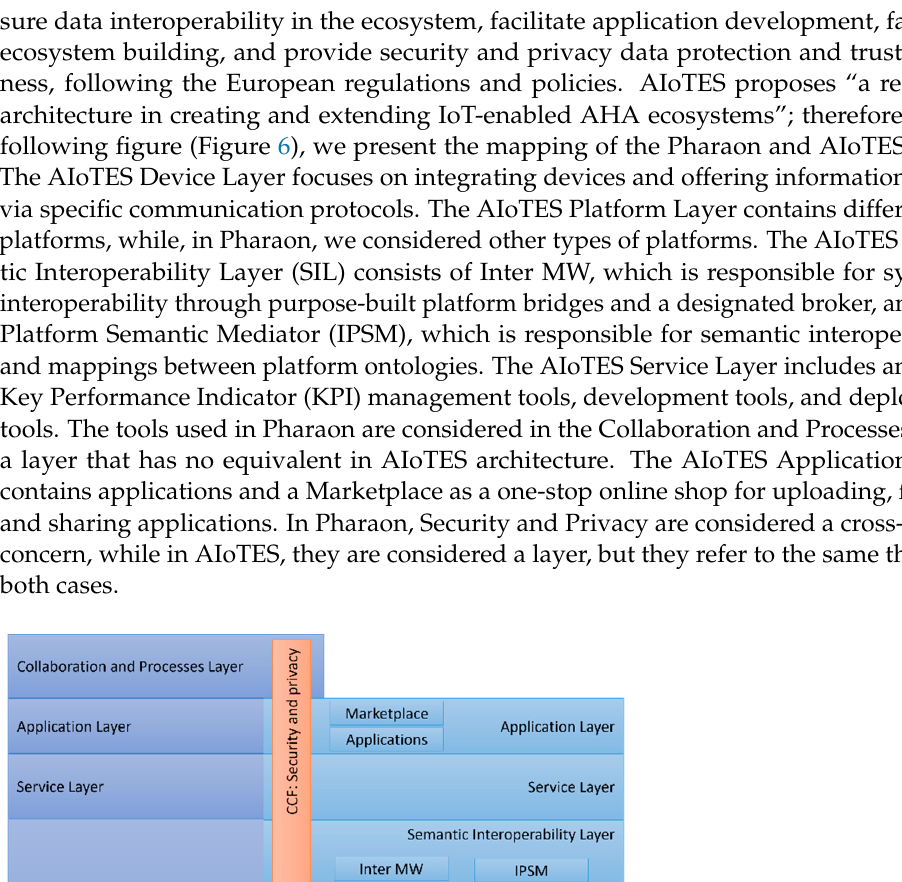
Figure 7. Pharaon ecosystem governance model.